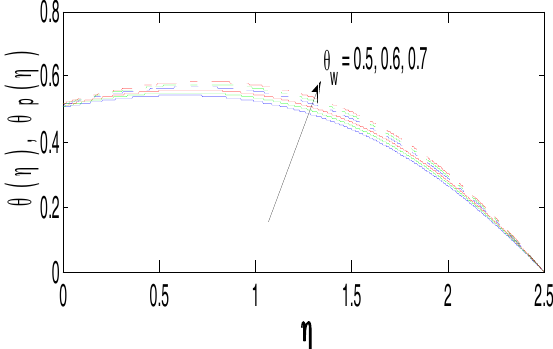
Figure 9. Impact of θ w on temperature profile θ and θ p of fluid with dusty particles.